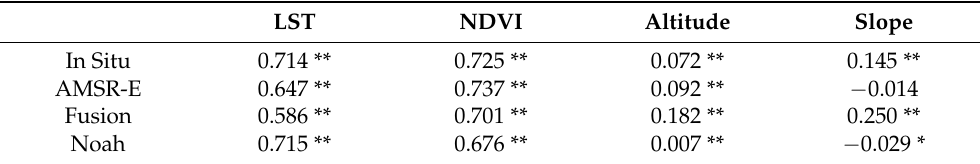
Table 5. The correlations between SSM and LST, NDVI, altitude, and slope. LST NDVI Altitude Slope In Situ 0.714 ** 0.725 ** 0.072 ** 0.145 ** AMSR-E 0.647 ** 0.737 ** 0.092 ** − 0.014 Fusion 0.586 ** 0.701 ** 0.182 ** 0.250 ** Noah 0.715 ** 0.676 ** 0.007 ** − 0.029